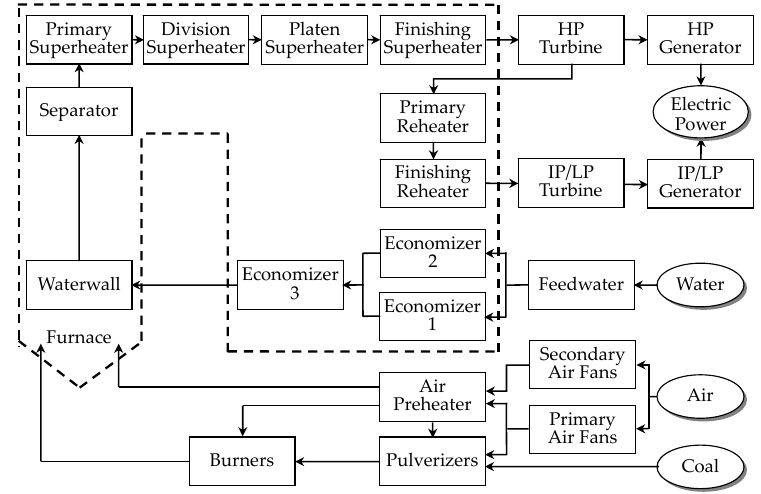
Figure 6. Schematic of a 1000 MW once-through-type thermal power plant.